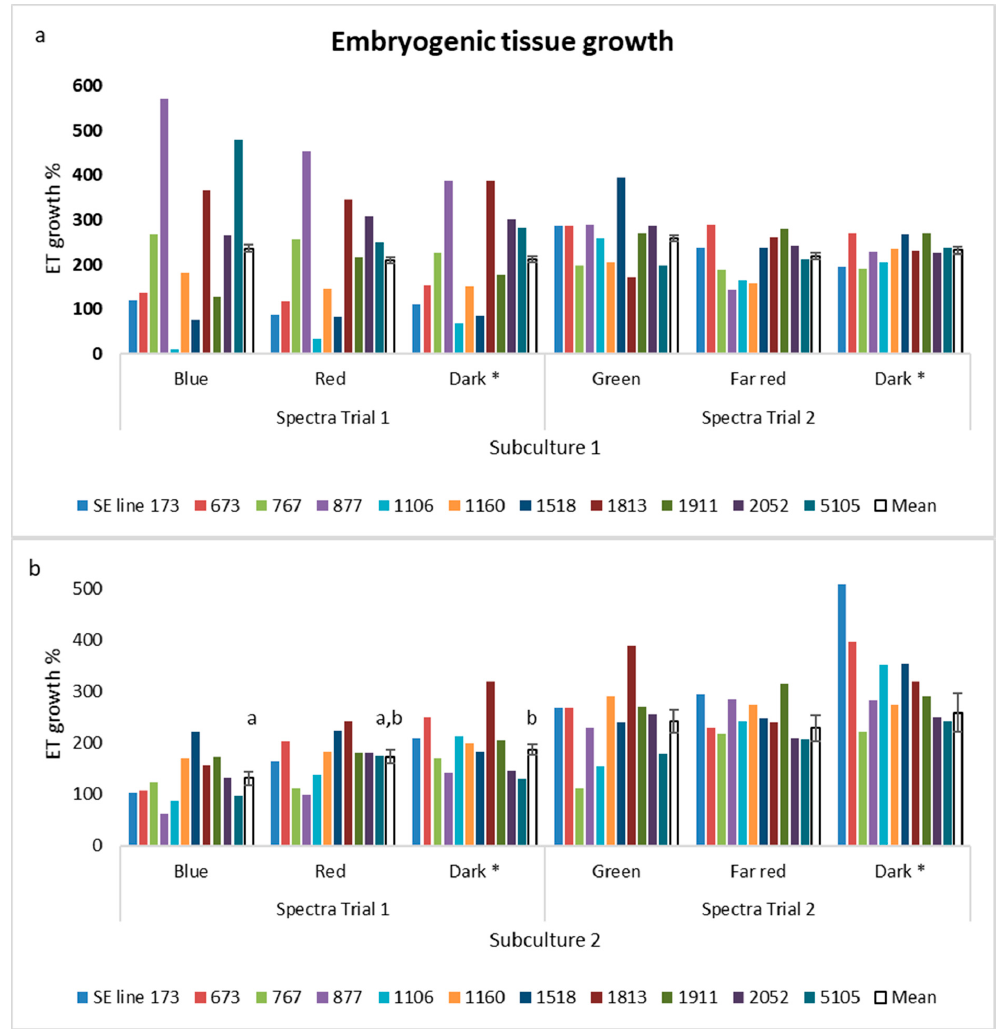
Figure 3. ( a , b ). Experiment I: the growth percentages of Norway spruce embryogenic tissue (ET) when 11 somatic embryogenesis (SE) lines were proliferated under different spectra. In the experiment one sample from each SE line was placed in each spectrum. The asterisk (*) represents the same control treatment in which the ET was proliferated, and somatic embryos were matured in the dark. The mean values of the SE lines combined (Total) are presented with standard error bars. Significant differences between the mean values within each trial are marked with differing letters. The 95% confidence level was